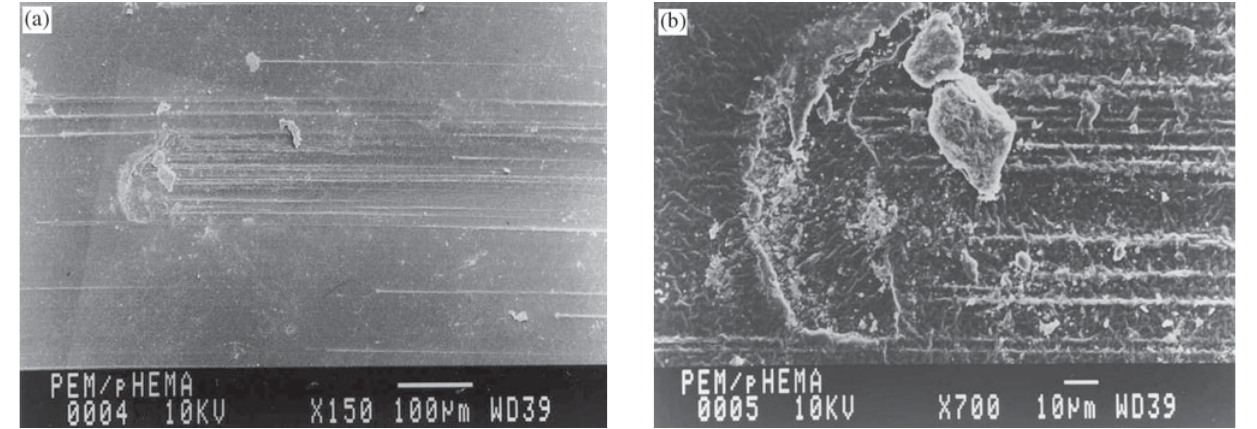
Figure 5. SEM worn surface of the pHEMA-PEM blend (a) and (b) detail of.